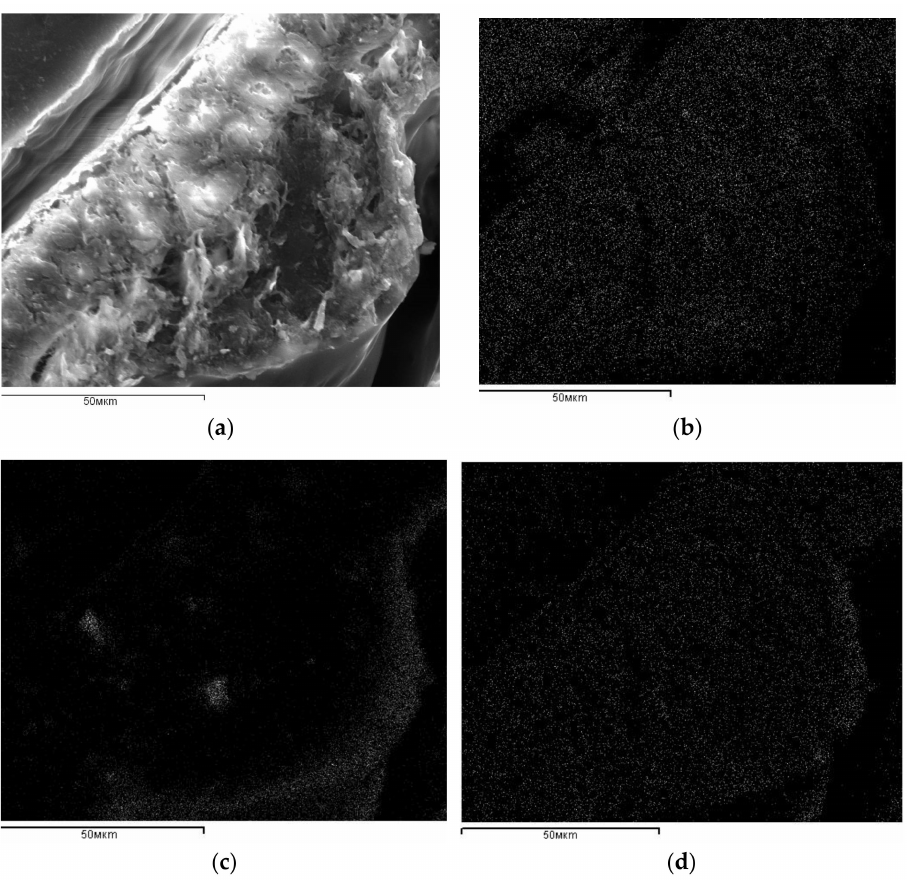
Figure 2. SEM micrographs of the rice husk sample: ( a ) longitudinal section of rice husk; ( b ) distribu- tion of carbon; ( c ) distribution of silicon; ( d ) distribution of